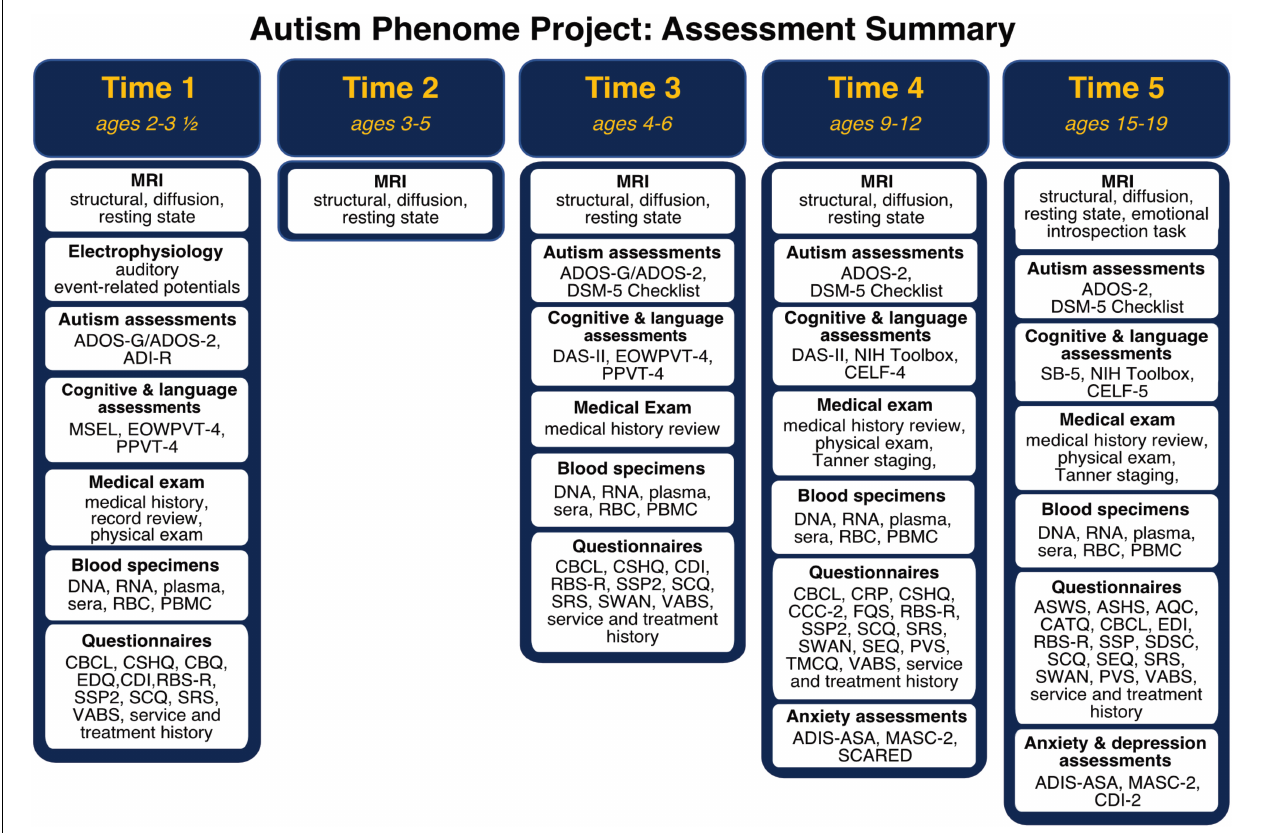
FIGURE 2 | Autism Phenome Project longitudinal study design and assessment battery at each time point from early childhood through adolescence. ADI-R, Autism Diagnostic Interview; ADIS-ASA, Anxiety Disorders Interview Schedule with Autism Addendum; ADOS, Autism Diagnostic Observation Schedule; AQC, Alexithymia Questionnaire for Children; ASWS, Adolescent Sleep Wake Scale; ASHS, Adolescent Sleep Hygiene Scale; CATQ, Camouflaging Autistic Traits Questionnaire; CBCL, Child Behavior Checklist; CBQ, Children’s Behavior Questionnaire; CCC-2, Children’s Communication Checklist; CDI-2, Child Depression Inventory; CDI, MacArthur-Bates Communicative Development Inventories; CELF, Clinical Evaluation of Language Fundamentals; CRP, Child Rearing Practices; CSHQ, Children Sleep Habits; DAS-II, Differential Ability Scale—2nd Edition; EDI, Emotional Dysregulation Inventory; EDQ, Early Development Questionnaire; EOWPVT, Expressive One Word Picture Vocabulary Test; FQS, Friendship Quality Scale; MASC-2, Multidimensional Anxiety Scale for Children; MSEL, Mullen Scales of Early Learning; PBMC, peripheral blood mononuclear cells; PPVT, Peabody Picture Vocabulary Test; PVS, Self-Perception Profile for Children and Peer Victimization Scales; RBC, red blood cells; RBS-R, Repetitive Behavior Scale—Revised; SB-5, Stanford Binet—Fifth Edition; SCARED, Screen for Child Anxiety Related Disorders; SCQ, Social Communication Questionnaire; SDSC, Sleep Disturbances Scale for Children; SEQ, Sensory Experiences Questionnaire; SRS, Social Responsiveness Scale; SSP2, Short Sensory Profile 2; SWAN, Strengths and Weaknesses of Attention-Deficit/Hyperactivity-symptoms and Normal-behaviors; TMCQ, Temperament in Middle Childhood; VABS, Vineland Adaptive Behavior